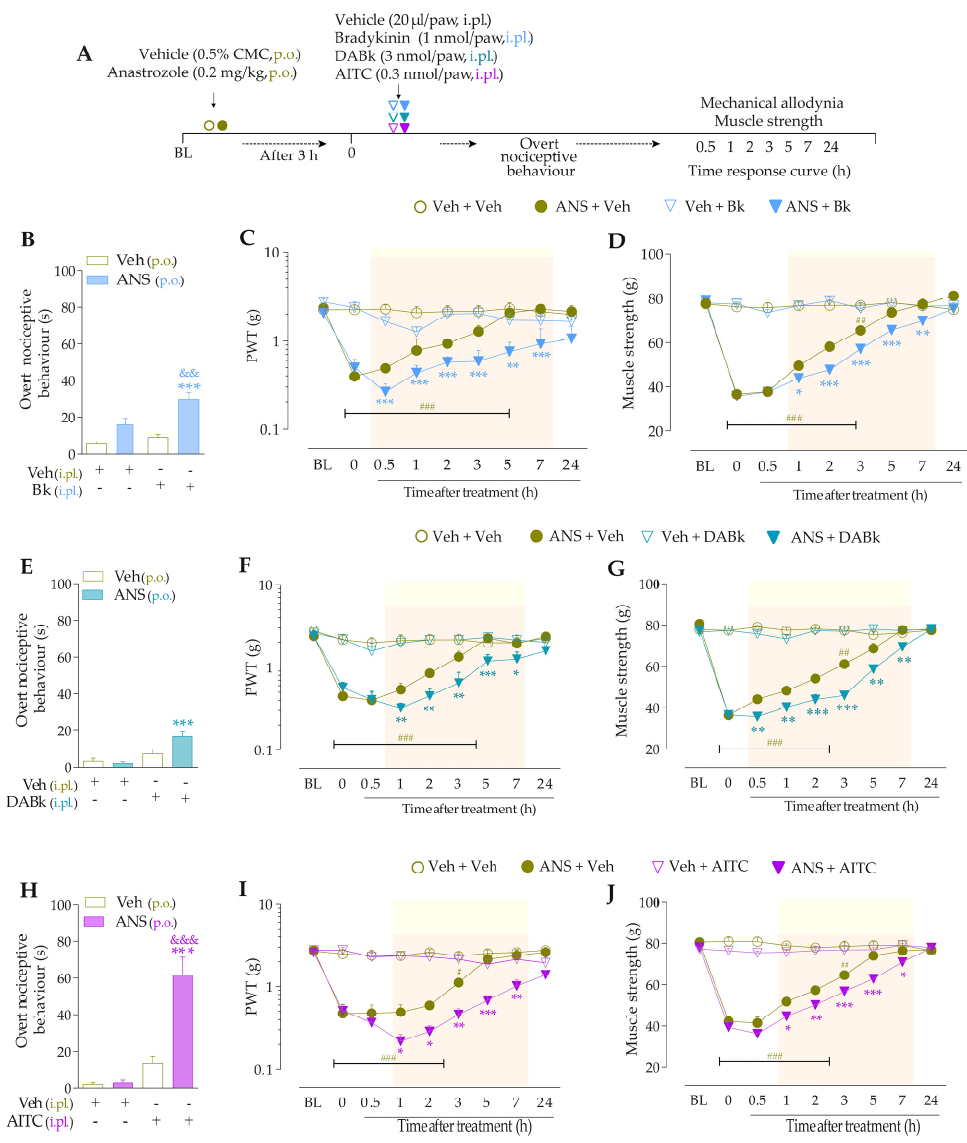
Figure 2. The nociceptive behaviors induced by anastrozole are enhanced and prolonged by local administration of B 2 R, B 1 R, and TRPA1 agonists in mice. ( A ) Male C57BL/6 mice treated by oral route (p.o.) with anastrozole (0.2 mg/kg) presented mechanical allodynia and muscle strength loss compared to their vehicle (0.5% CMC). At 3 h after anastrozole administration (Time 0), the vehicle (20 µL/paw, intraplantar, i.pl.) or sub-nociceptive doses of Bk (1 nmol/paw, i.pl., B 1 R agonist), DABk (3 nmol/paw, i.pl., B 2 R agonist), or AITC (0.3 nmol/paw, i.pl., TRPA1 agonist) were injected by the intraplantar route. The overt nociceptive behavior was immediately evaluated for 10 min ( B , E , H ); the PWT ( C , F , I ) and muscle strength ( D , G , J ) were assessed from 0.5 h up to 24 h after agonists’ sub-nociceptive doses. Baseline (BL) values were measured before the anastrozole or vehicle administration. # p < 0.05, ## p < 0.01, and ### p < 0.001 vs. Veh plus Veh group. * p < 0.05, ** p < 0.01, and *** p < 0.001 vs. ANS plus Veh group. && p < 0.01 and &&& p < 0.001 vs. Veh plus Bk/AITC group. Data were expressed as the mean + SEM (n = 6/group) and analyzed by one- or two-way ANOVA followed by the Bonferroni post hoc test. Veh: intraplantar, intraperitoneal, or oral vehicle injections; ANS: anastrozole oral administration; Bk: bradykinin intraplantar treatment; PWT: paw withdrawal